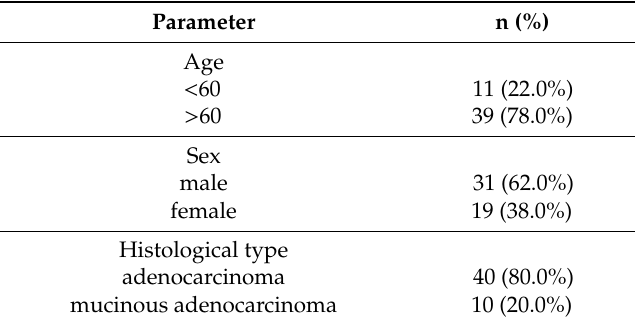
Figure 1. A. Colorectal adenocarcinoma without mucinous component. B. Adenocarcinoma with Figure 1. ( A ) Colorectal adenocarcinoma without mucinous component. ( B ) Adenocarcinoma with mucinous component. H+E staining. mucinous component. H + E staining. Table 1. Characteristics of study Table 1. Characteristics of study group.